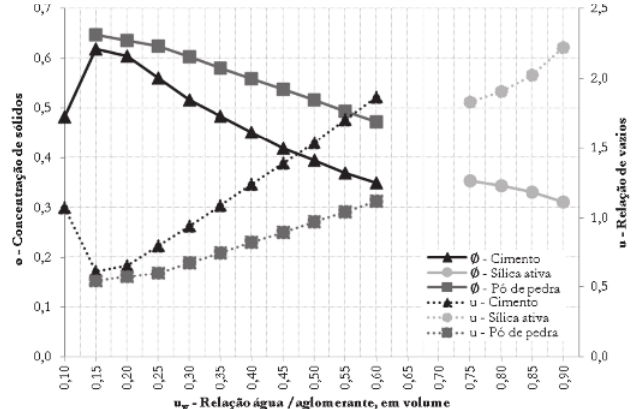
Resultados de concentração de